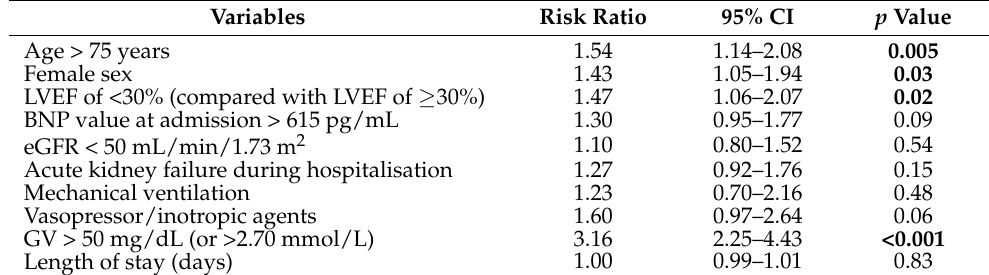
Table 4. Multivariate Cox proportional-hazards regression analysis for MACE.